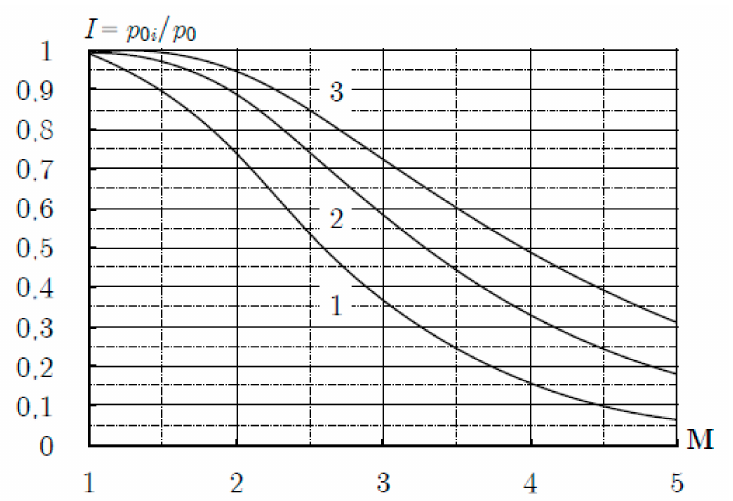
Figure 9. Dependence of the recovery factor of the total pressure behind the shock system on the Mach number, γ = 1.4. Line1 corresponds to the normal shock, line 2 corresponds to one oblique and one normal shock, and line 3 corresponds to two oblique shocks and one normal